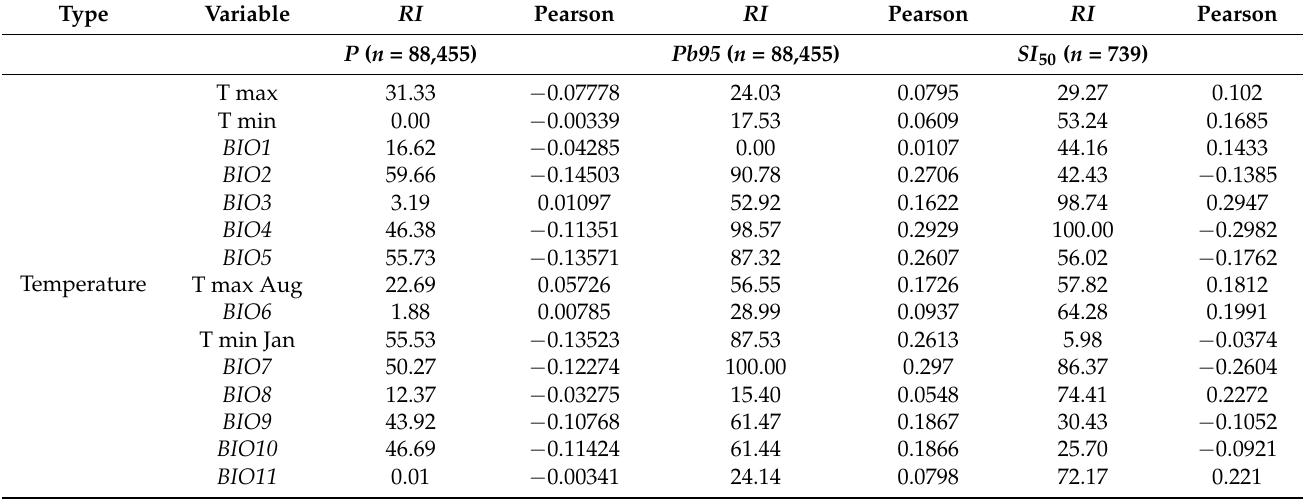
Table A2. Relative importance analysis to obtain a ranking regarding the significance of each regressor variable to the species distribution ( Pb95 and P ) and productivity ( SI 35 ) modelling in ML tree classification and